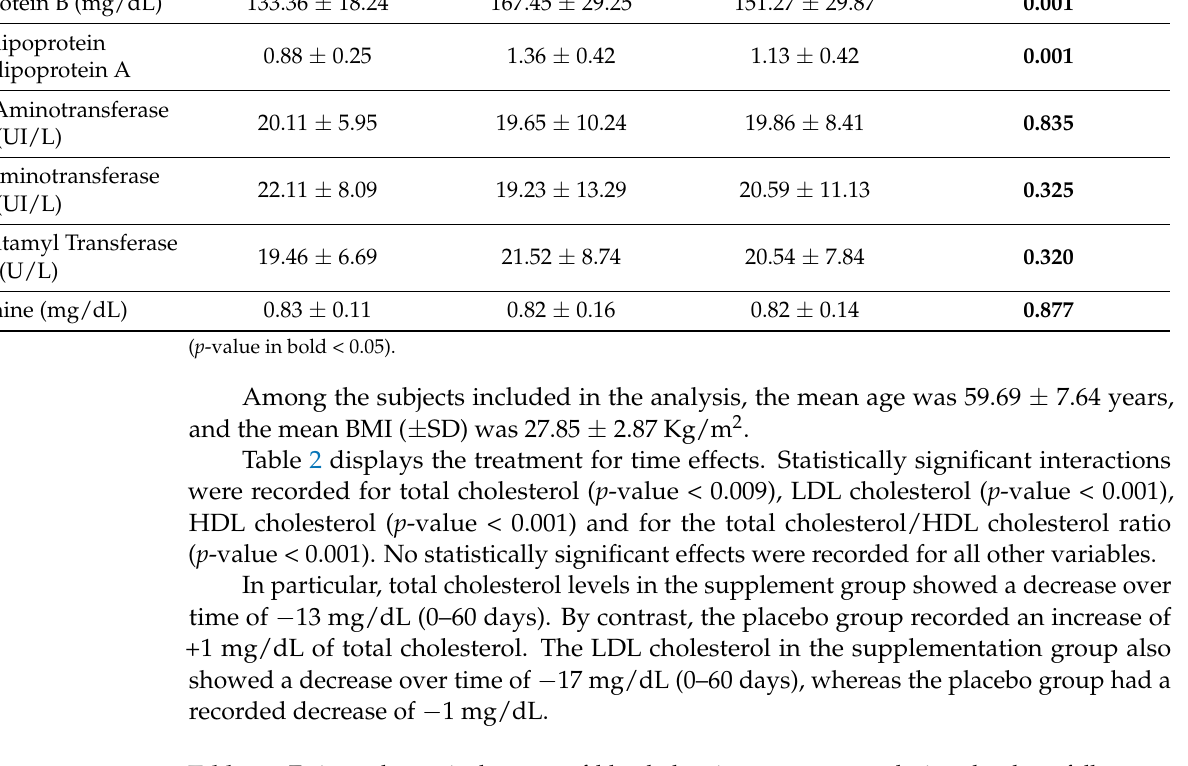
Table 2. Estimated marginal means of blood chemistry parameters during the three follow-ups —supplementation for